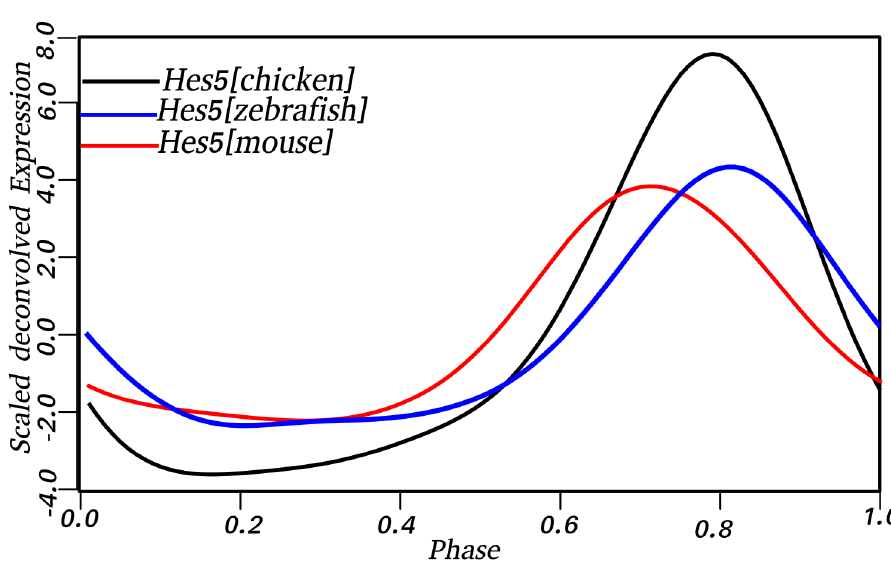
Fig 2. Hes5 cyclic expression is conserved between mouse, chicken and zebrafish. The expression pattern of Hes5 is shown as periodic during mouse, chicken and zebrafish somitogenesis. Moreover, the oscillations are in phase in all three species as depicted by the expression profile. Phase of gene expression varies from 0 to 1 and corresponds to 120, 90, and 30 minutes periodicity of mouse, chicken, and zebrafish